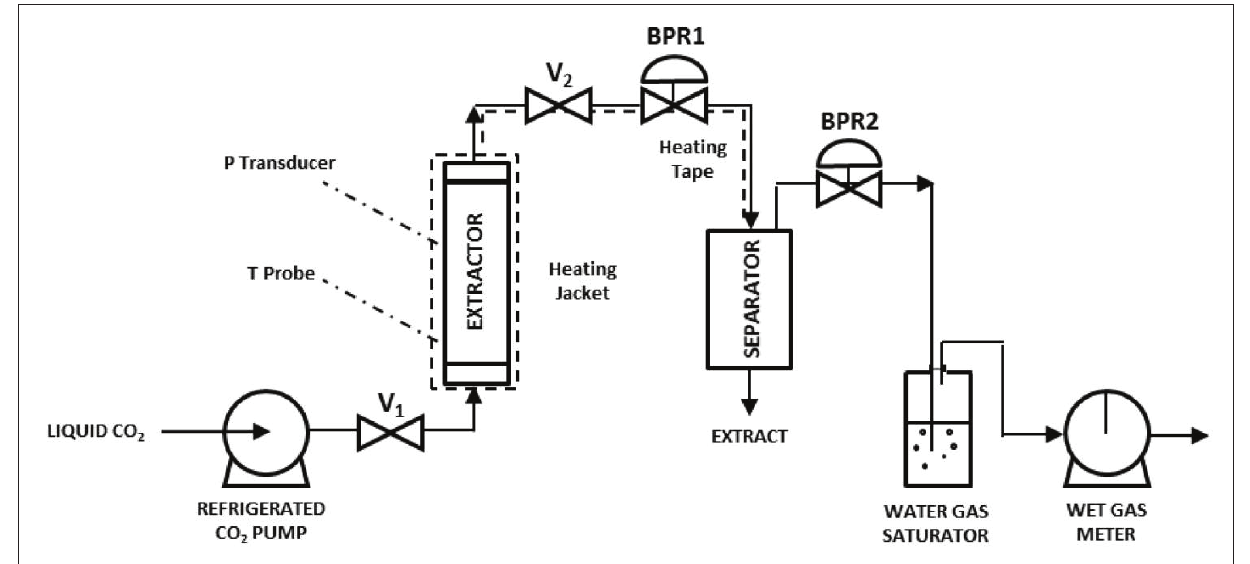
Fig. 1 – SFE system: V